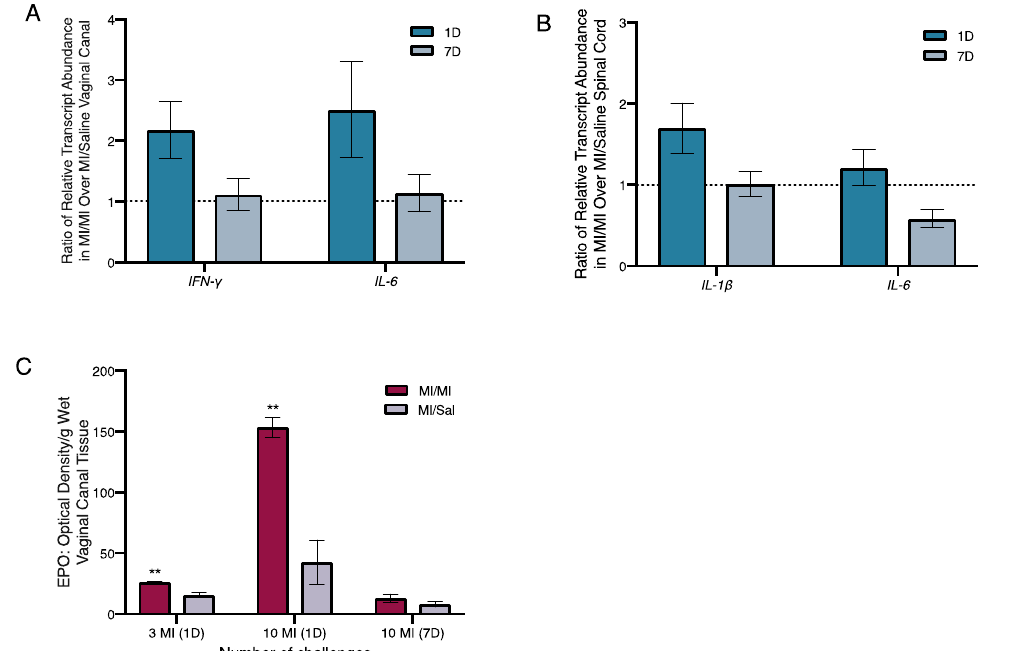
Figure 4. Inflammatory changes in the vaginal canal and spinal cord, and increased eosinophil activity after 10 intra-vaginal MI challenges in previously sensitized ND4 female mice. Relative transcript abundance of interferon-γ (IFN-γ) and interleukin (IL)-6 transcripts in the vaginal canal tissue ( A ) and IL-1β and IL-6 in spinal cord tissue ( B ) of MI challenged mice one and seven days after 10 challenges, normalized to β2-microglobulin mRNA levels; 5–6 mice/treatment group. Black dotted line denotes no change in the relative abundance of transcripts. ( C ) Tissue eosinophil peroxidase levels measured by optical density (OD)/g of wet tissue, in the vaginal canal of mice one day after the 3rd and 10th MI challenge; 3–5 mice/treatment group. Significance with respect to vehicle control group ** p < 0.01. EPO, eosinophil peroxidase.